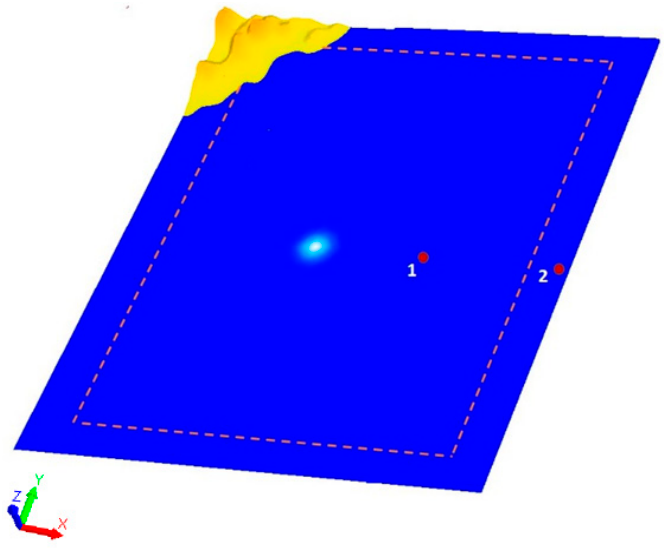
Figure 7. Problem schematic.